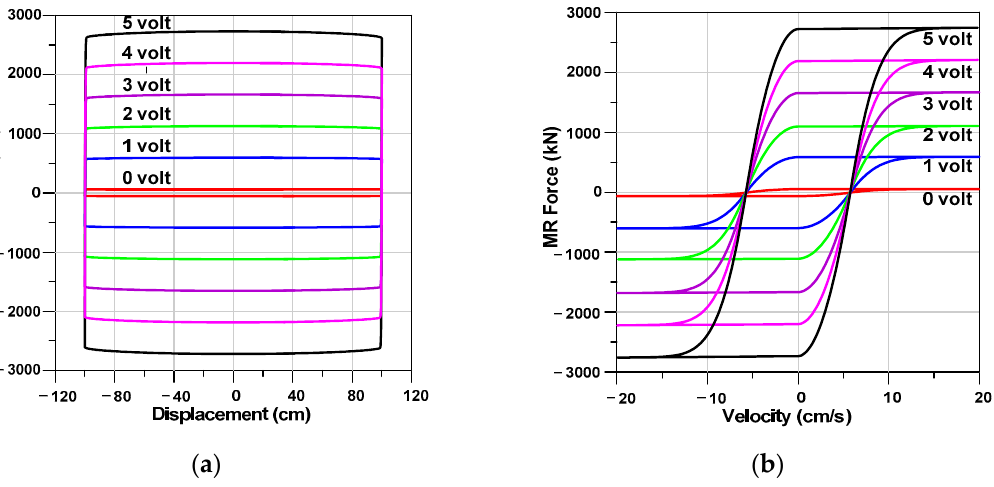
Figure 6. Hysteresis loops of the MR damper: ( a ) displacement—force hysteresis loop, ( b ) velocity– force hysteresis loop.